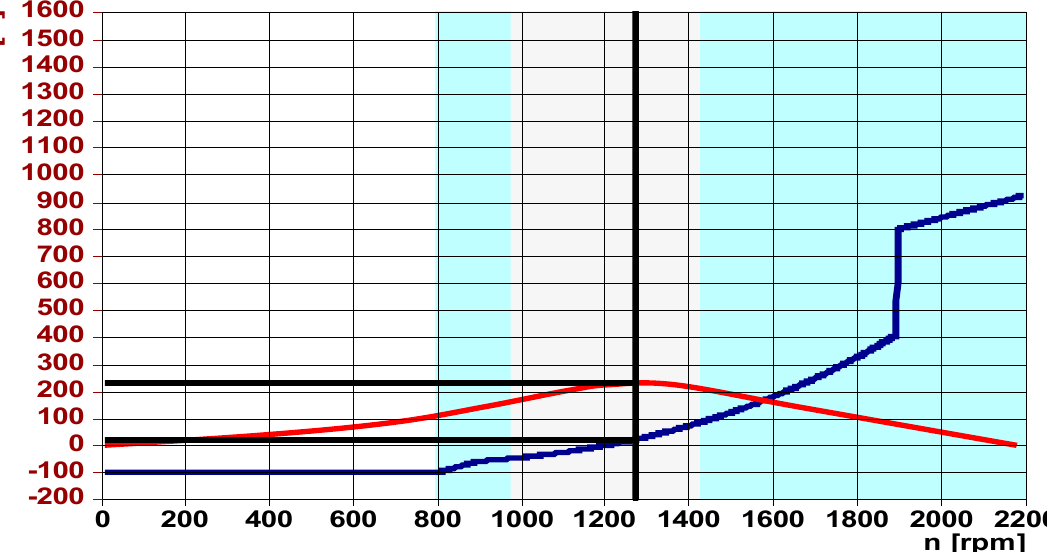
Figure 18. A wind turbine based on DFIG with a speed of 5.2 m/s. Figure 19 shows the figures obtained when the wind speed was equal to 4.5 m/s . Total power ((cid:1842) (cid:3047)(cid:3042)(cid:3047) ) = −80 W , mechanical power ((cid:1842) (cid:3040)(cid:3032)(cid:3030) ) = 80 W , rotation speed ((cid:1840)) = 911 r. p. m. as shown by a black vertical line, voltage sag = 100% , of the voltage line to line ( (cid:1848) ((cid:3013)(cid:2879)(cid:3013)) ). Power at the line side converter ((cid:1842) (cid:3039)(cid:3046) ) = −100 W as shown by an horizontal blue line and power at the generator side (cid:3435)(cid:1842) (cid:3034)(cid:3032)(cid:3041) (cid:3439) = 25 W The inertia moment ((cid:1839)) = 0.9 Nm and the wind turbine based on DFIG was working as a motor instead of working as generator because of voltage sag as shown in Table 1 and recorded by using fault ride through (FRT).